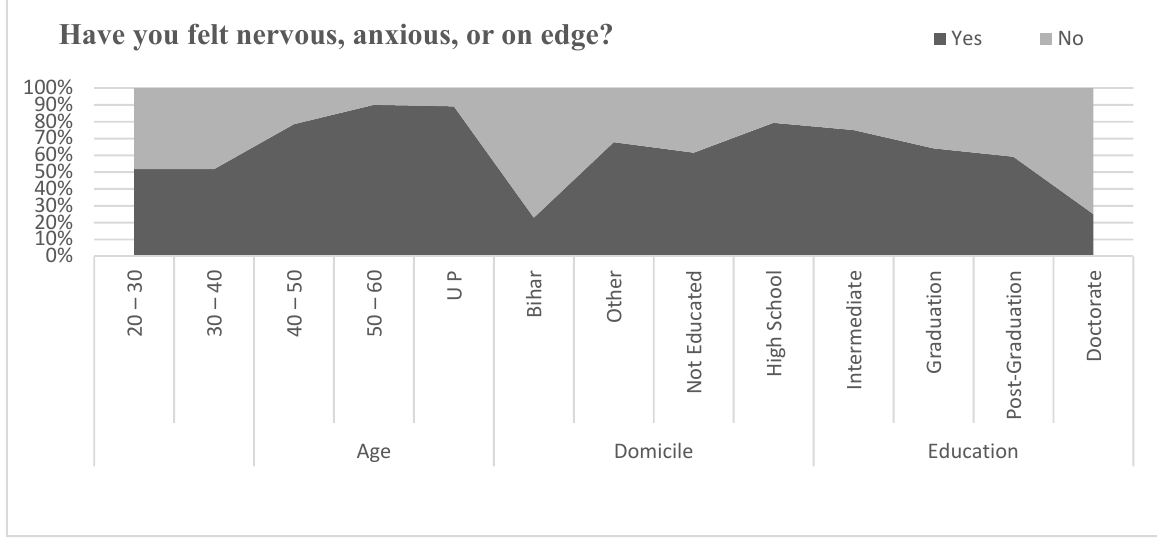
Figure 3. Comparison of feeling nervous.